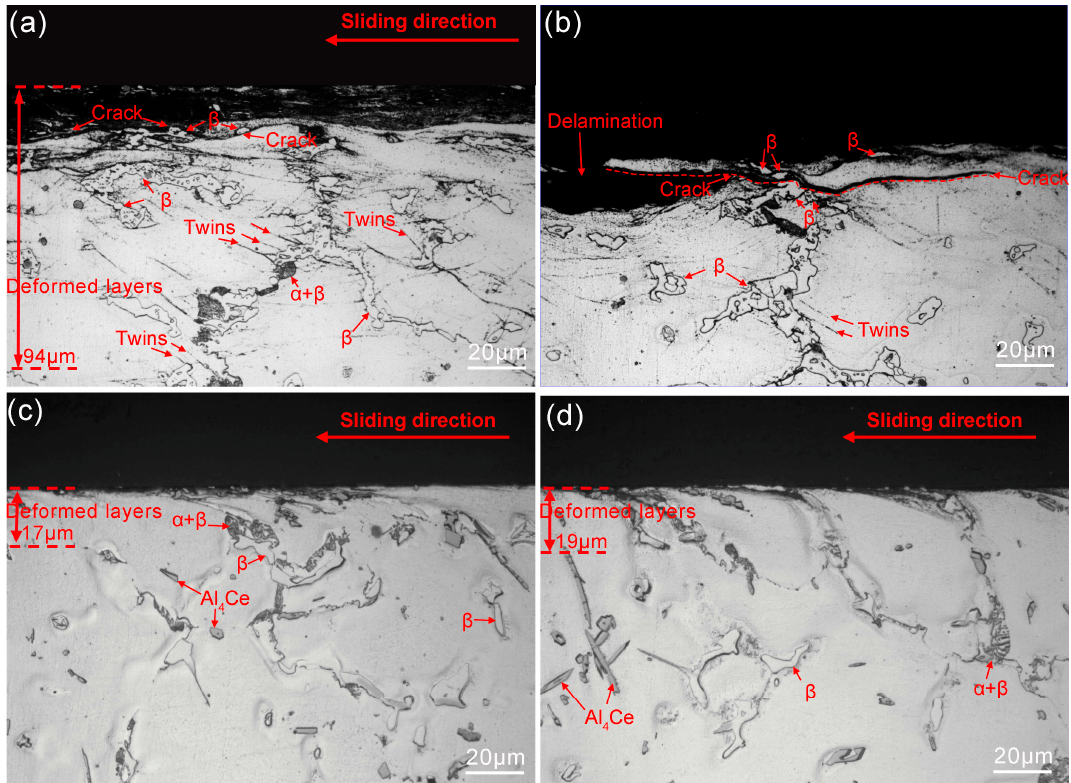
Figure 8. Micrographs of the subsurface of surfacing alloys after sliding under an applied load of 10 N and sliding speed of 1.25 m/s. ( a , b ) surfacing AZ91 alloy with 0% Ce; ( c ) surfacing AZ91 alloy with 1.5% Ce; ( d ) surfacing AZ91 alloy with 3% Ce.